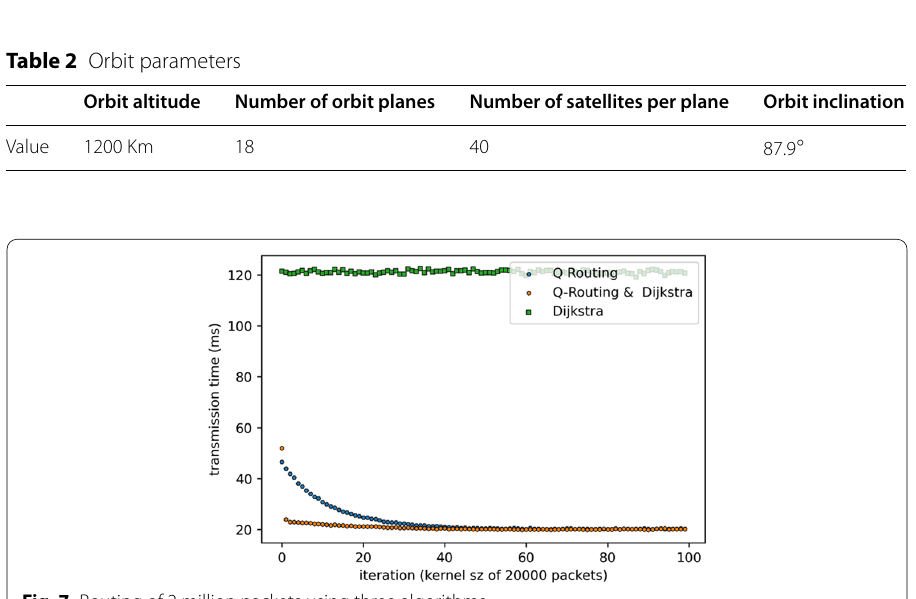
Space complexity and time complexity of Dijkstra algorithm and Q‑routing algorithm